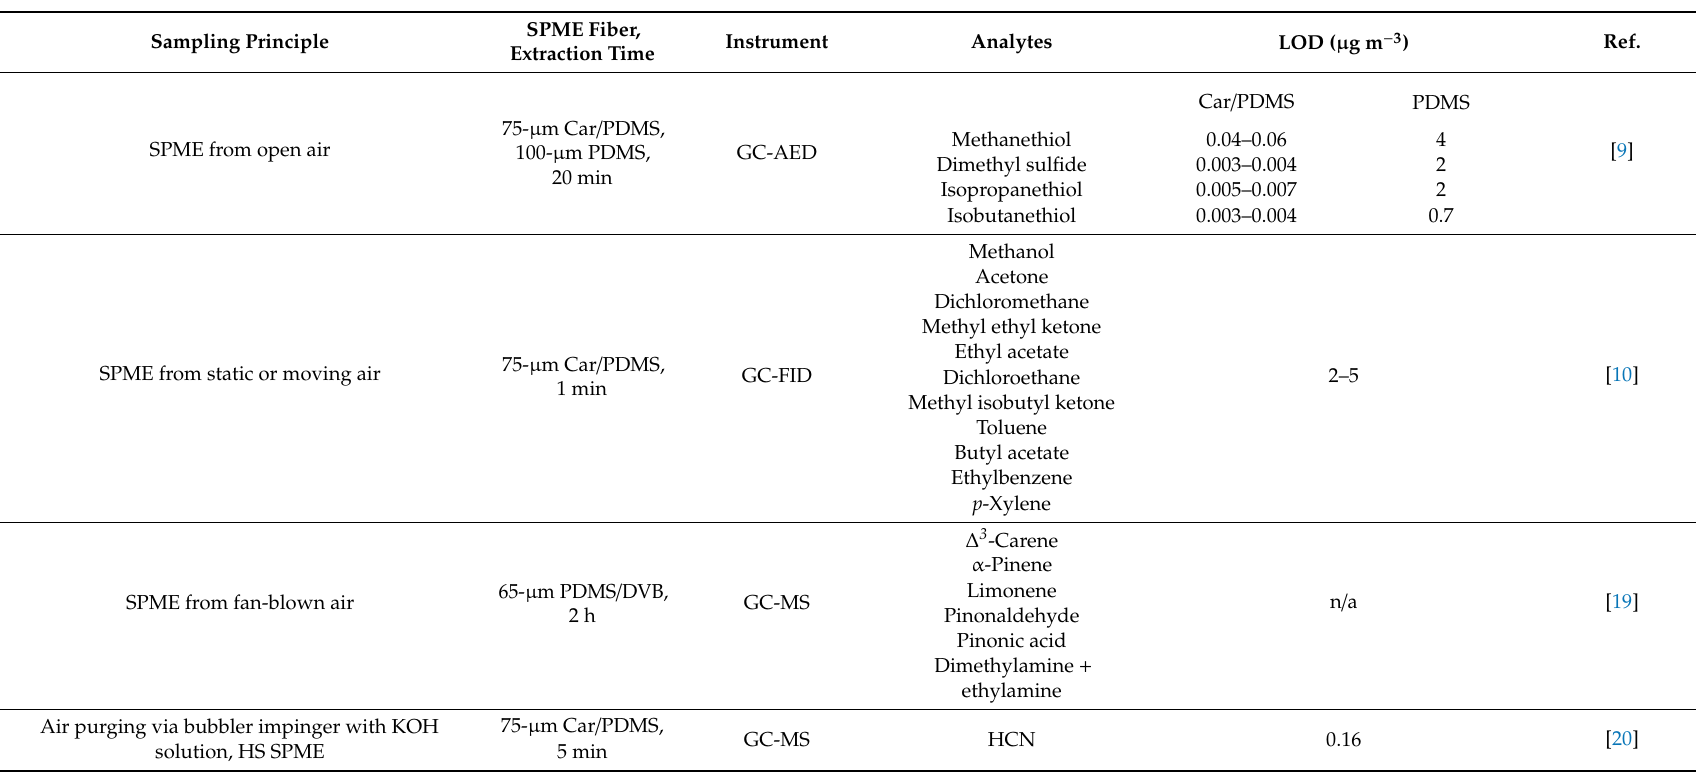
Table 1. Methods for quantification of organic compounds in ambient air by exposed solid-phase microextraction (SPME)